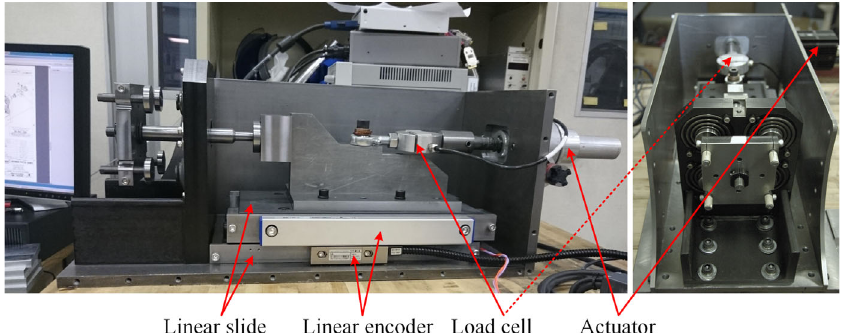
FIG. 12. Spring unit calibration system. The side panel and the actuator motor have been removed in the photo on the left and are in place in the photo on the